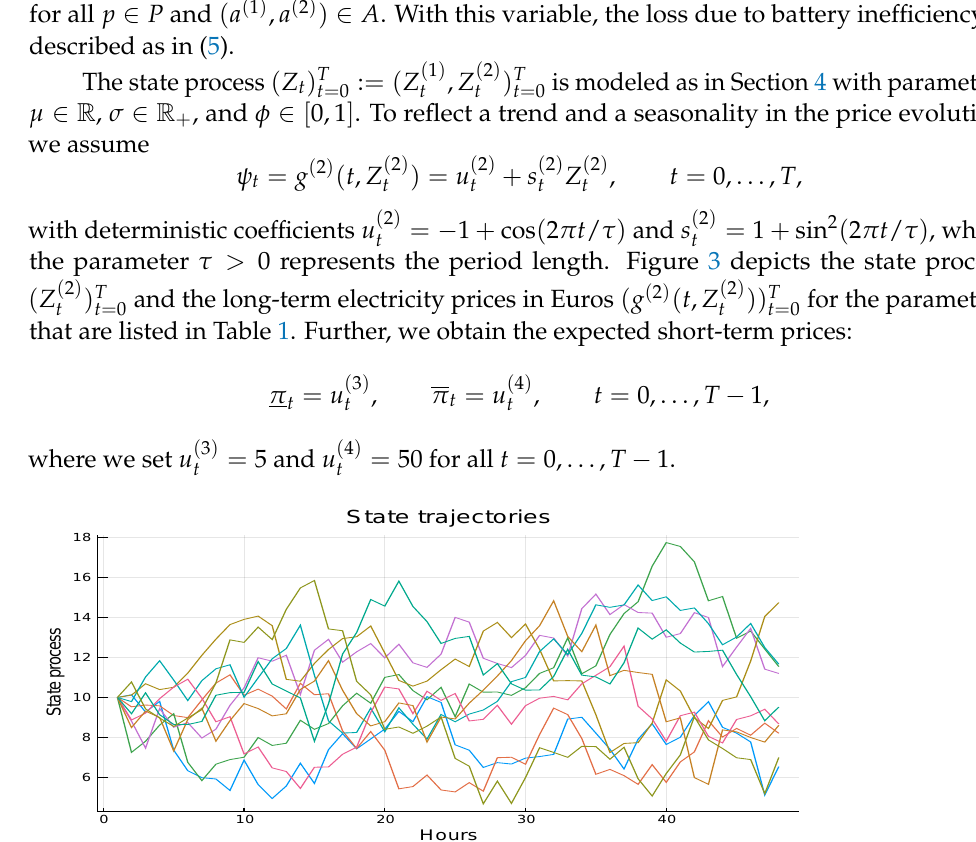
, respectively. t = 0